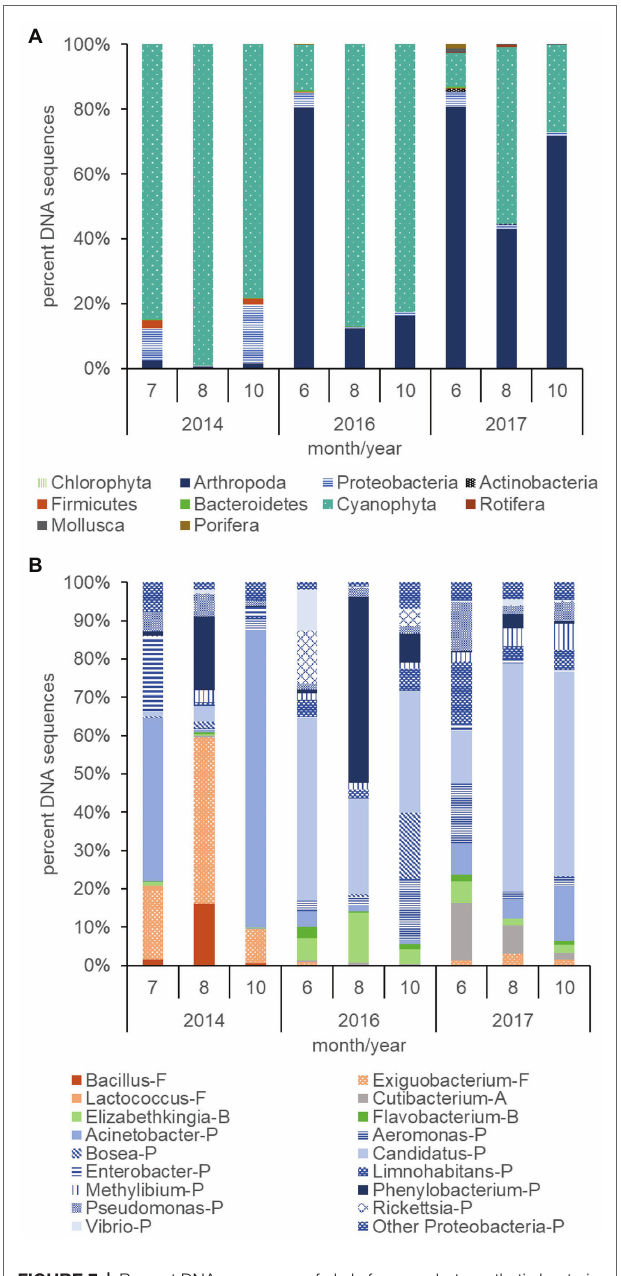
than nitrogen fixed by diazotrophs.